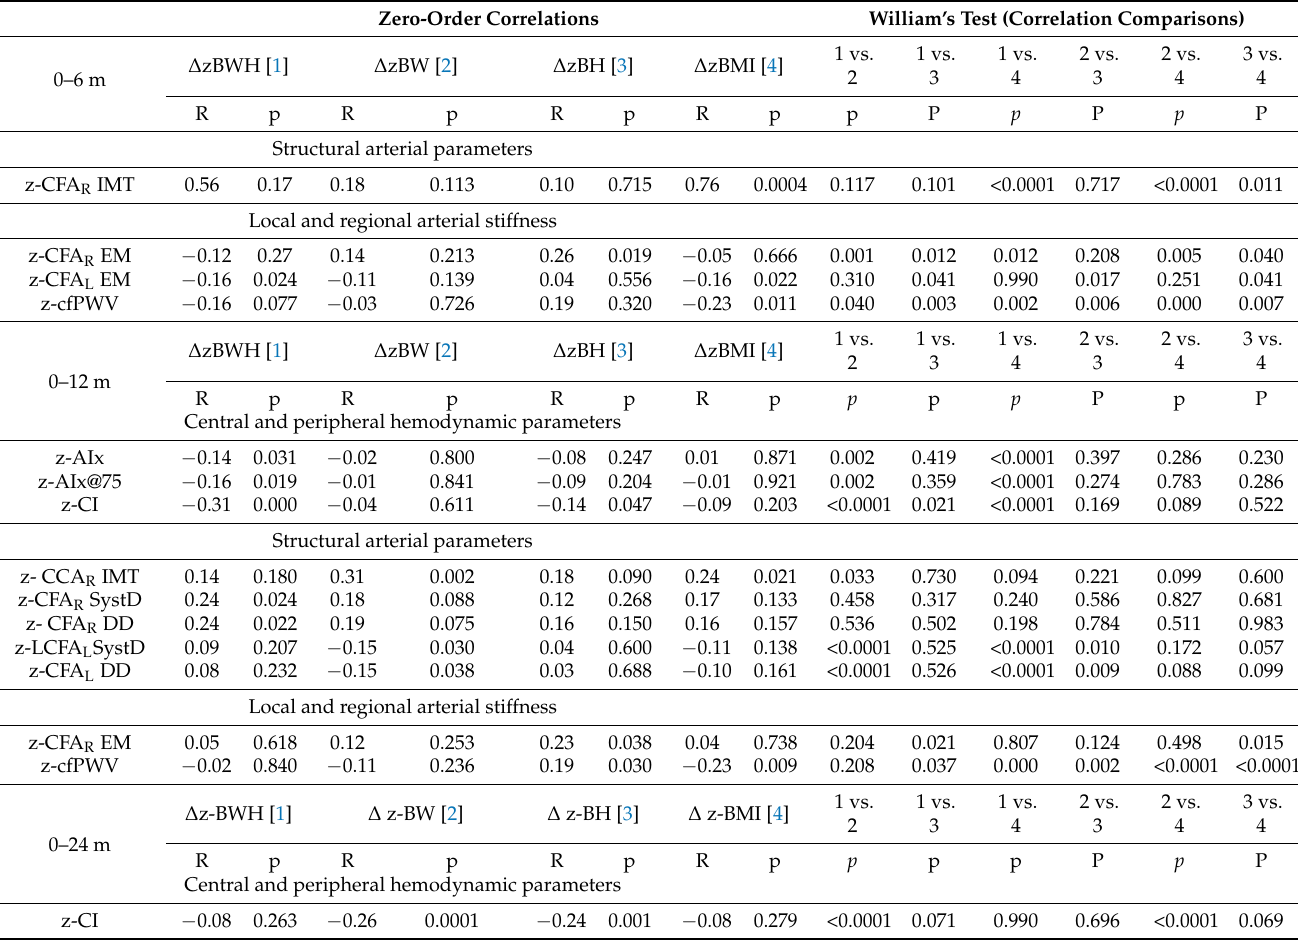
Table 4. Comparison of correlations between arterial z-scores at age 6 years and anthropometric variations in different growth periods (0–6, 0–12, 0–24 and 12–24